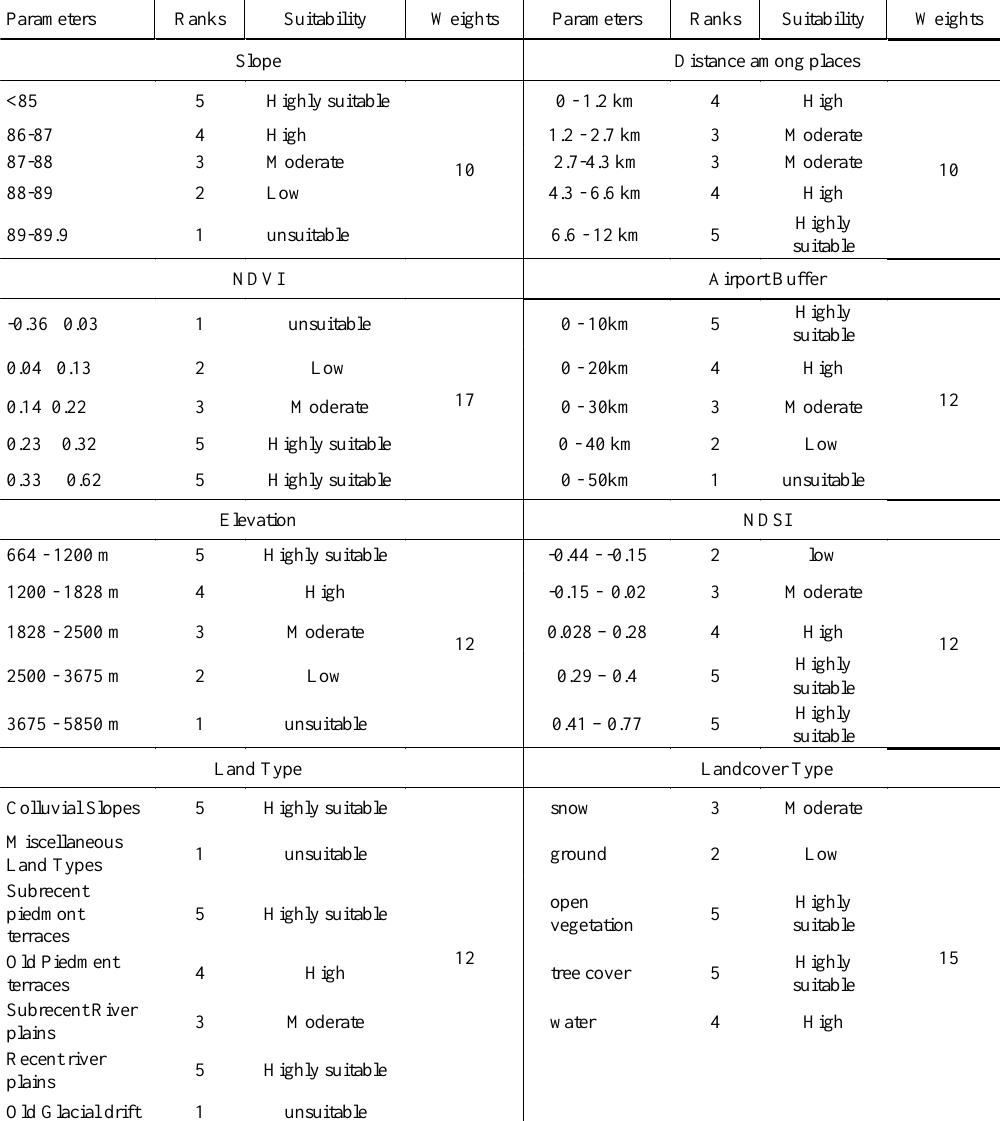
Table 1: Spatial data rankings and weights for weighted overlay